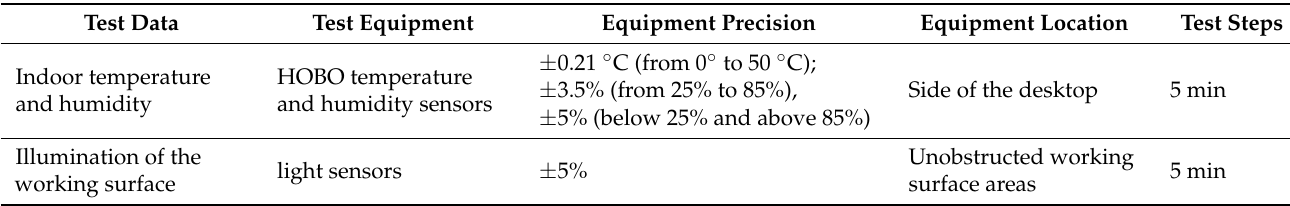
Figure 4. ( a ) HOBO temperature and humidity sensors, ( b ) Mijia light sensors. Table 1. Indoor test parameters and instruments.